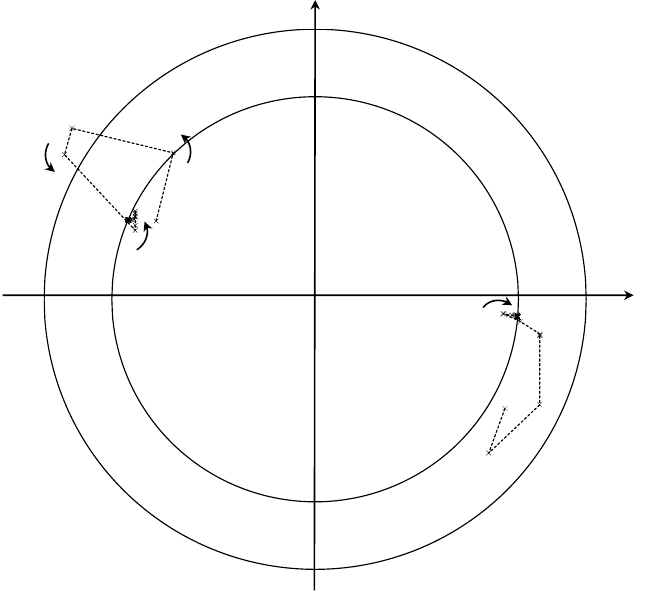
Figure 4. Convergence of selected voltages at buses 2 and 5 at time period